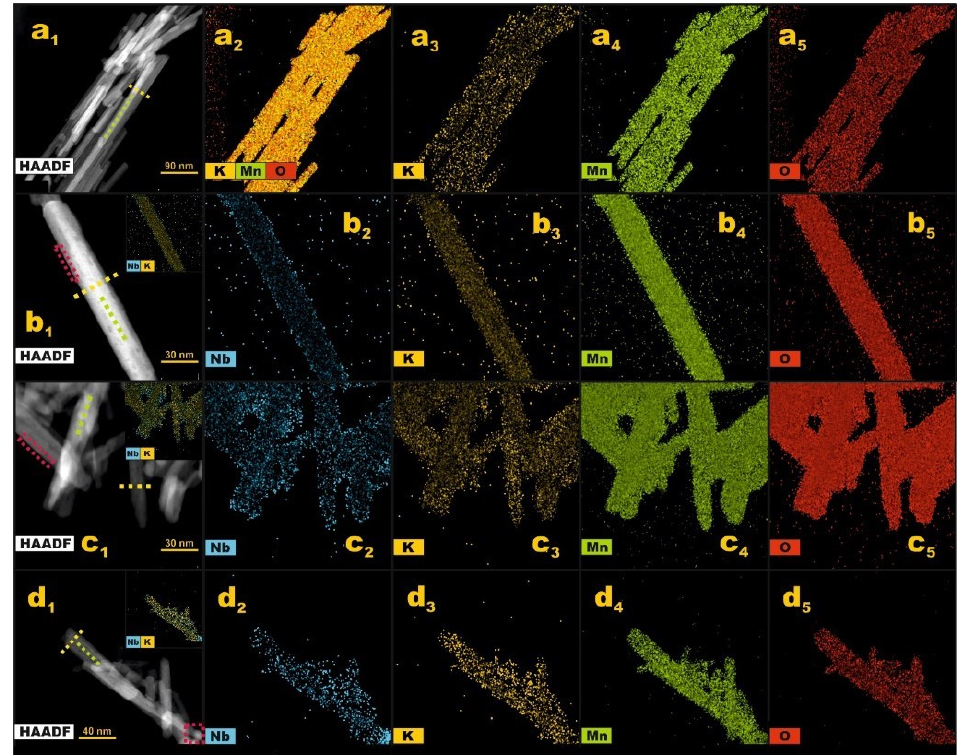
Figure 3. HAADF STEM ( a 1 ) and EDX ( a 2 – a 5 ) analysis of K-OMS-2 nanorods. The corresponding analysis was performed for niobium-doped cryptomelane nanorods (Nb / K-OMS-2): 3 wt% Nb ( b 1 – b 5 ),